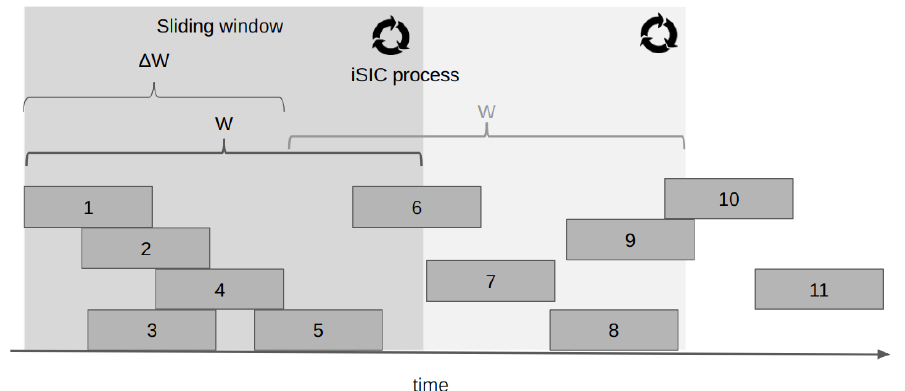
Figure 12. Example of operation of enhanced spread spectrum Aloha (E-SSA) protocol. The sliding window of length W is shifted in ∆ W after performing the iterative process of interference cancellation (ISIC) in the current window. Figure adapted from